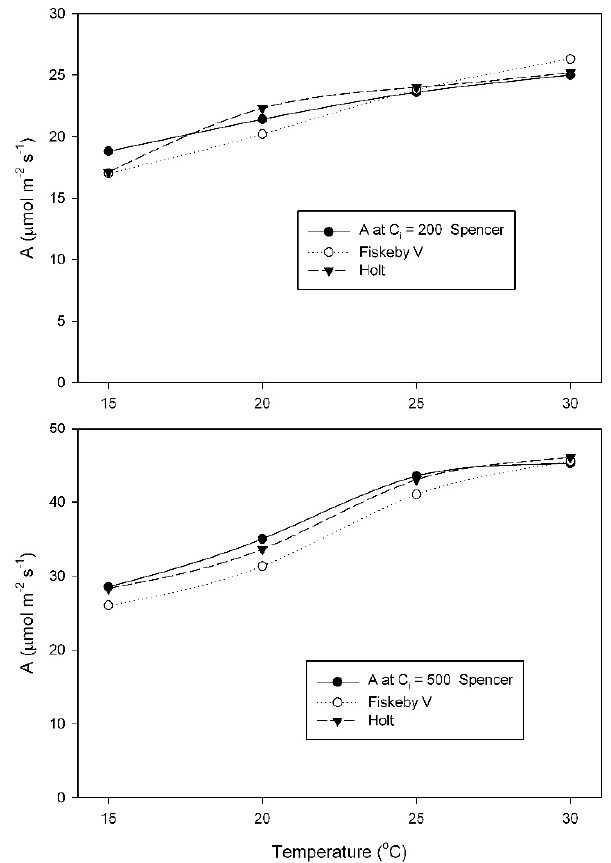
Figure 3. Values of A measured at either C i = 200 μ mol mol − 1 , or at C i = 500 μ mol mol − 1 CO 2 for three soybean cultivars grown at 20 °C. Each point represents a mean for 3 or 4 leaves. Statistical comparisons are given in Tables A3 and A4.